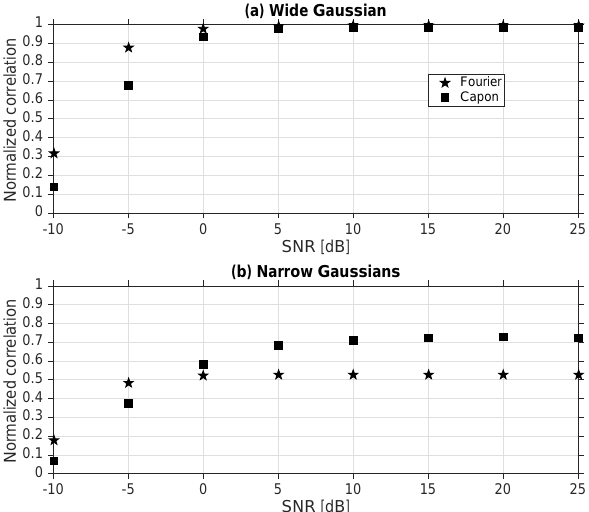
Figure 4. Simulation results describing the performance of the Fourier and Capon methods as a function of SNR conditions for two scattering distribution scenarios: (a) the brightness distribution is described by a single wide Gaussian function and (b) by two nar- row Gaussian functions. Each correlation estimate is an average of correlations obtained for 1000